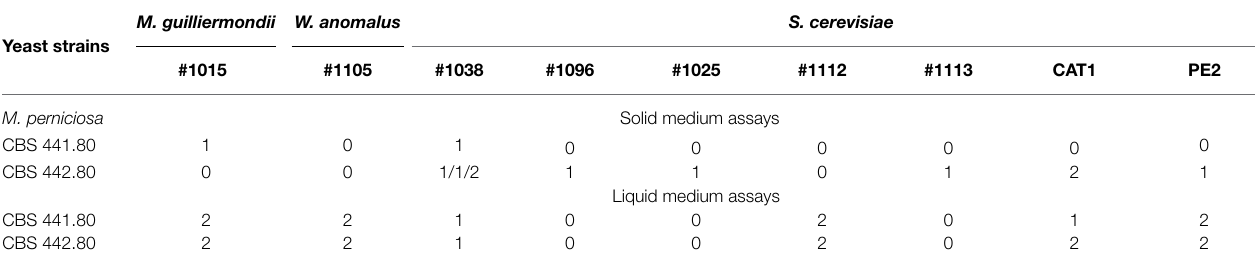
TABLE 3 | Results of the antagonism assays between M. perniciosa and yeasts in solid and liquid media.